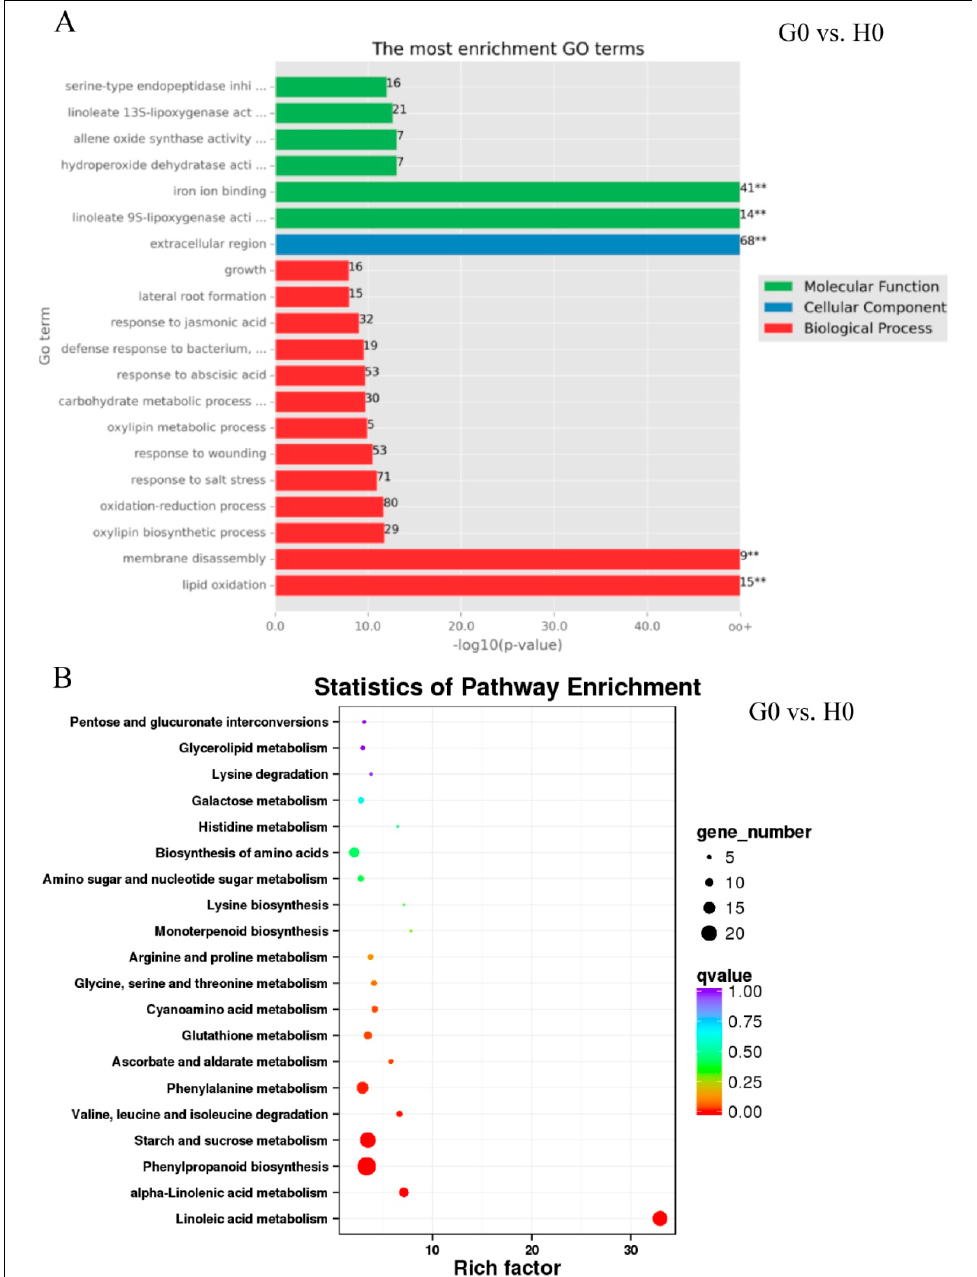
Figure 5. The top 20 enriched GO terms and KEGG pathways. ( A ) GO enrichment analysis of genes differentially expressed in response to glycerol. Data are presented according to the p -value. The names of the 20 most highly enriched GO terms are arranged on the vertical axis according to the − log 10 ( p -value); the horizontal axis represents the − log 10 ( p -value). ** indicates highly significant differences from H0 group at p ≤ 0.01 by Student’s t -test. ( B ) Statistical scatterplot showing the pathways enriched in genes differentially regulated in response to glycerol. The color represents the Q-value as shown in the legend. Q-values are p -values corrected for multiple hypothesis testing and range from 0 to 1. The closer the Q-value is to zero, the more significant the enrichment. The horizontal axis indicates the rich factor, which means that the ratio of the DEGs number and the number of genes are annotated in this pathway. The greater the rich factor, the greater degree of enrichment. The size of each circle indicates the number of DEGs in that pathway. The bigger the circle, the greater number of DEGs.